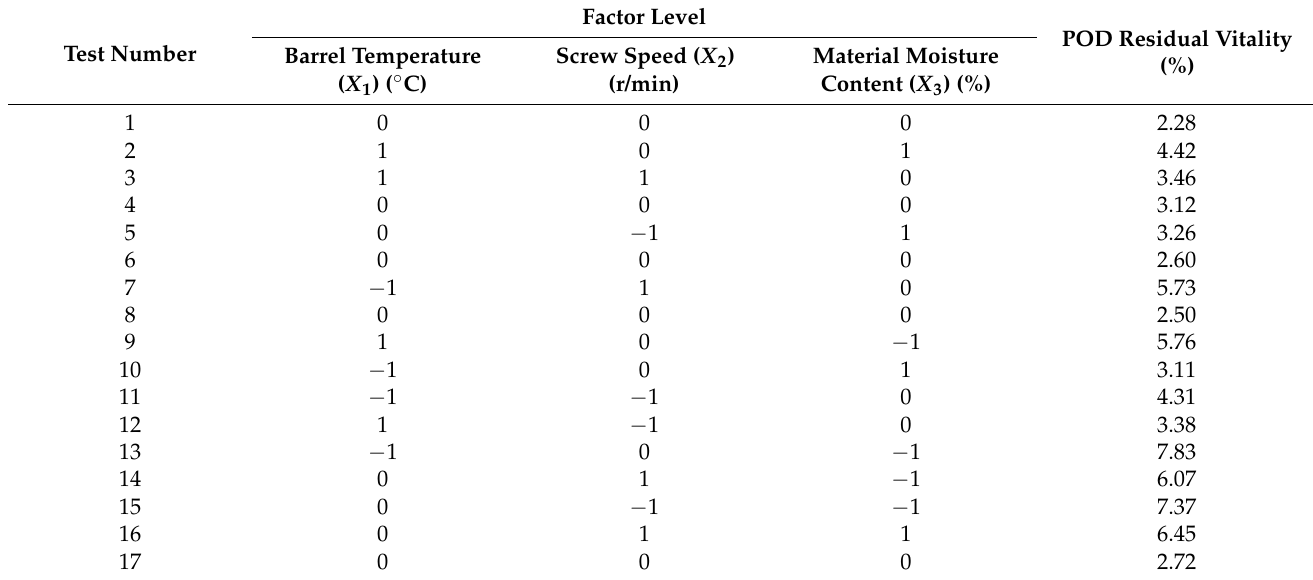
Table 2. Response surface optimization (Box–Behnken design) of residual peroxidase